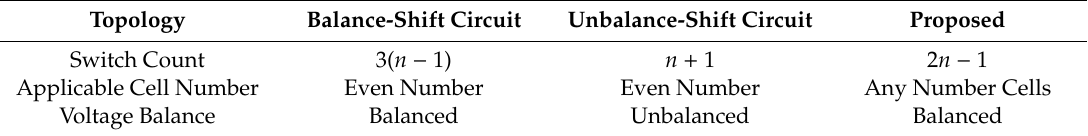
Table 1. Comparison among conventional and proposed reconfiguration